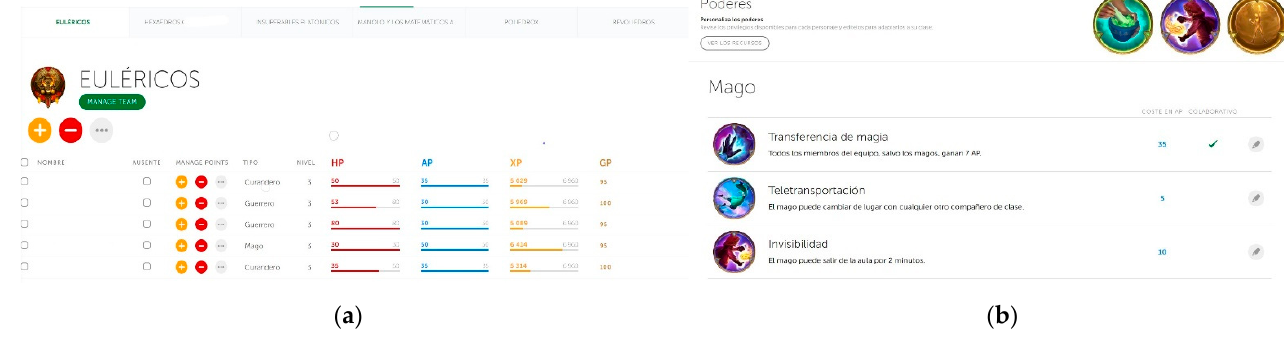
Figure 4. ( a ) leader board of one of the cooperative groups; ( b ) powers from wizards in Classcraft.